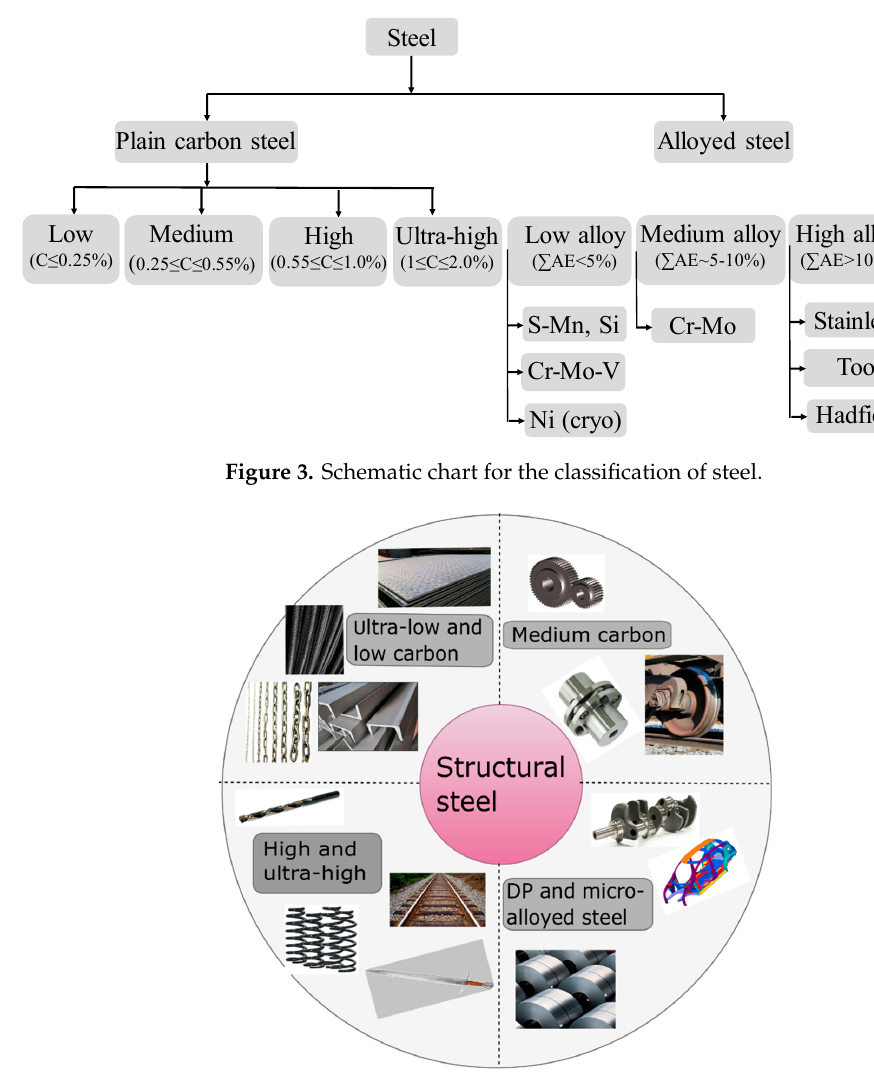
Figure 4. Applications of structural steels.